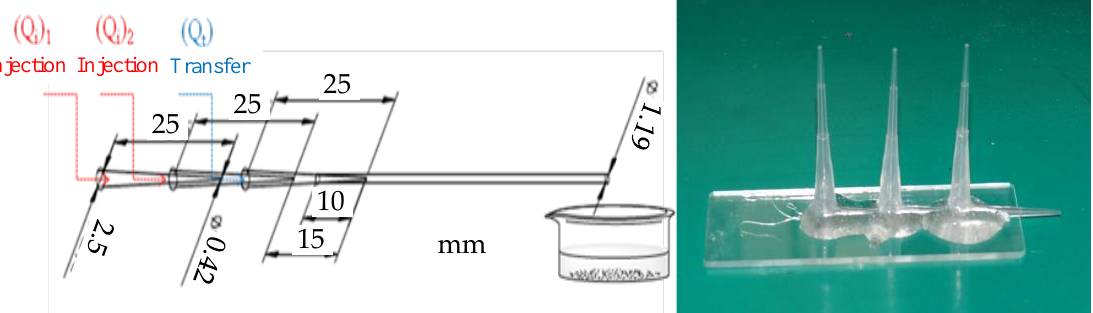
Figure 4. Three-tube microfluidic device ( left ) chart, ( right ) entity picture. Next, 70 g (1%) alginate aqueous solution, 0.2 g sodium dodecyl sulfate, and 30 g tea